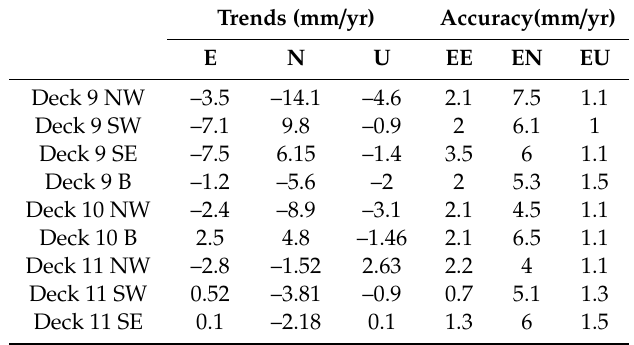
Figure 3. Three-dimensional displacement rate of deformation of the Morandi bridge between 2015 and 2018 (in mm / yr). Inferred value of deformation using the Markov chain Monte Carlo (MCMC) approach described in the methodology section. All displacement components refer to the coordinate system at the bottom right. North, West and Up axes are characterized by independent arbitrary scales for visualization purposes. Line of sight displacement rates used as inputs are listed in Table 2. MCMC outputs are listed in Table 3 and Figure 2. Table 3. Three-dimensional deformation trends from di ff erent satellites and line of sight recorded during the period 2018–2015. West, average and east are referred to the west and east is referred to the closest point located at the deck level near the strands, while average refers to the average displacement of the deck. “ / ” indicates no PS coverage in the area. Deck –11 refers to the balanced system numbers as listed in Figure 1. E,N,U refer to East, North and Up, E prefix indicates error. B indicates bottom. 2018–2010 trends for CSK data are presented in Table S2.